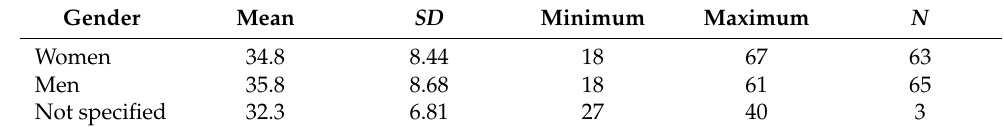
Table 5. Descriptive statistics for age and gender of the participants that completed the online questionnaire.